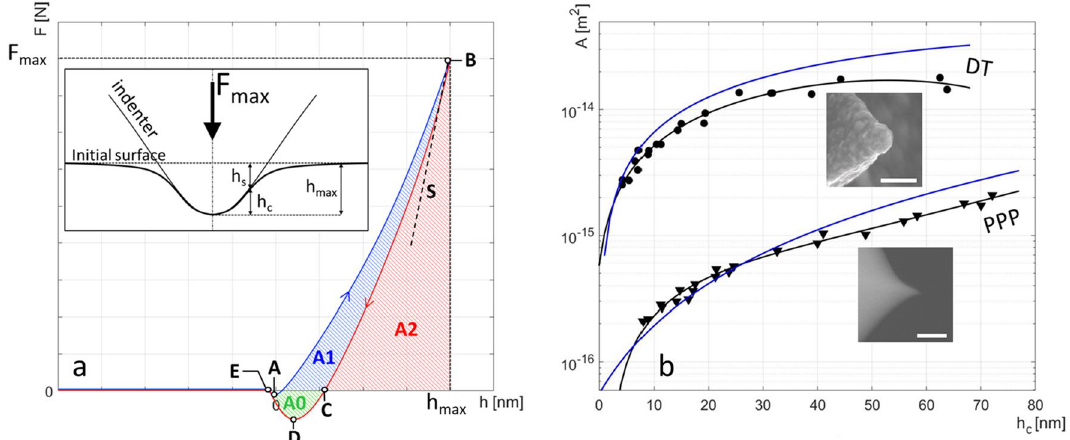
Figure 2. Overview of the indentation curve processing and area function calibration procedure. Inset: scheme of tip-surface interaction during indentation at maximum load. ( a ) Typical indentation measurement with loading (blue) and unloading curves (red). The hatched areas A0, A1 and A2, are used for characterization of adhesion and viscoplasticity respectively. ( b ) Contact area function for both DT and PPP probes as a function of indentation depth h c using AFC method (data points-black symbols- and fits-black lines) and adjusted spherical-conical models (blue lines, Supplementary Section S1). Insets: Electronic microscopy of DT (scale bar = 400 nm) and PPP tips (scale bar = 100